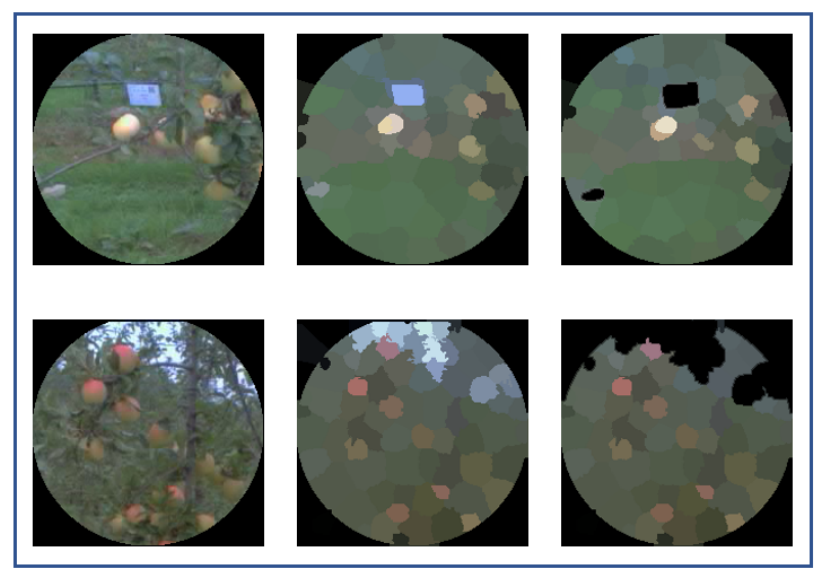
Figure 4. Color thresholding to remove blueish color belonging to the sky or blue tree-labels on superpixel segmented attention areas. Each row represents from left to right: the attention area, the superpixel segmented attention area, and the thresholded one,